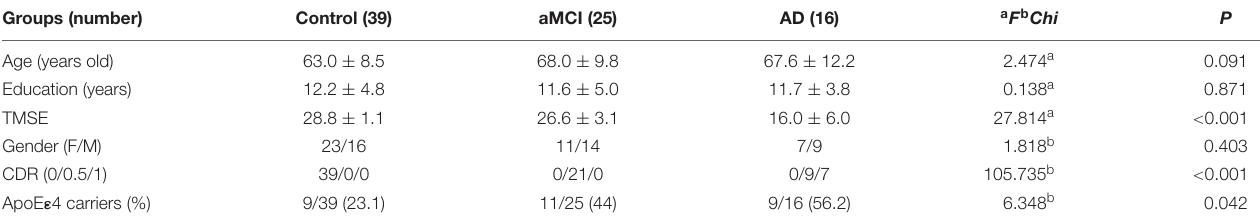
TABLE 1 | Demographic and clinical information of the three groups.